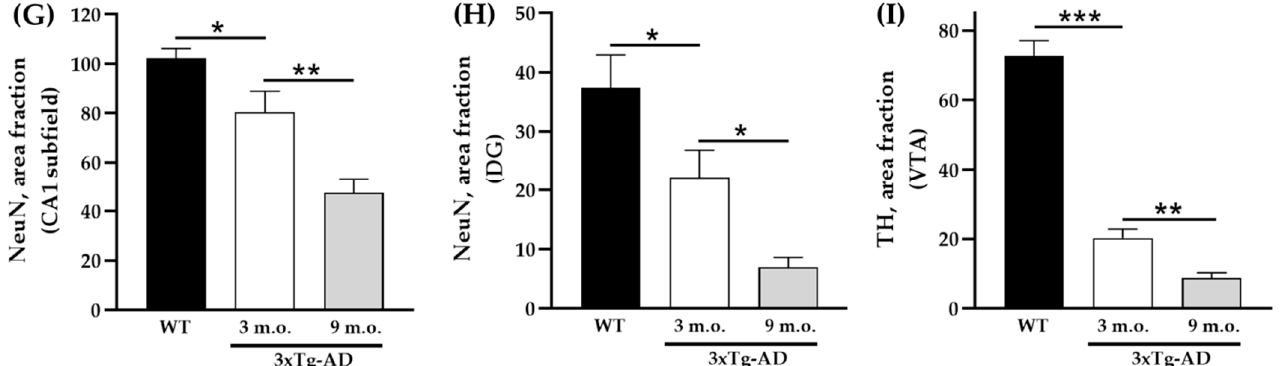
Figure 2. Biomarker expression in transgenic mice with AD-like neuropathology. Photomicrographs of brain sections from WT ( n = 3–4) and APP/BIN1/COPS5 3xTg-AD ( n = 3–4) mice showing histo- pathological lesions identified with immunohistochemical biomarkers. ( A – C ) Transverse sections of the dentate gyrus (DG) and CA1 area of the hippocampus in WT- ( A ) and APP/BIN1/COPS5 3xTg-AD mice ( B , C ), showing strong differences in NeuN immunoreactivity (white arrows). ( D – F ) VTA highlighting the notable reduction in TH-stained cells (white arrows) in the female APP/BIN1/COPS5 3xTg-AD mouse brain ( E , F ), compared to WT mice ( D ). Area fraction analyses of the CA1 subfield ( G ) and DG ( H ) of the hippocampus, and VTA in the midbrain ( I ), found reduc- tions in NeuN and TH immunoreactivities, respectively, in 3-m.o.- and 9-m.o.-3xTg-AD mice versus WT animals. Data represent mean ± S.E.M. One-way ANOVA followed by Tukey’s post hoc com- parisons, * p < 0.05, ** p < 0.01, *** p < 0.001. Scale bars, 100 μ m. 3xTg-AD, triple-transgenic mouse model of AD; CA1, cornu Ammonis 1; DG, dentate gyrus; m.o., month-old; NeuN, neuronal nuclear protein; SN, substantia nigra; TH, tyrosine hydroxylase; VTA, ventral tegmental area; WT, wild- type.